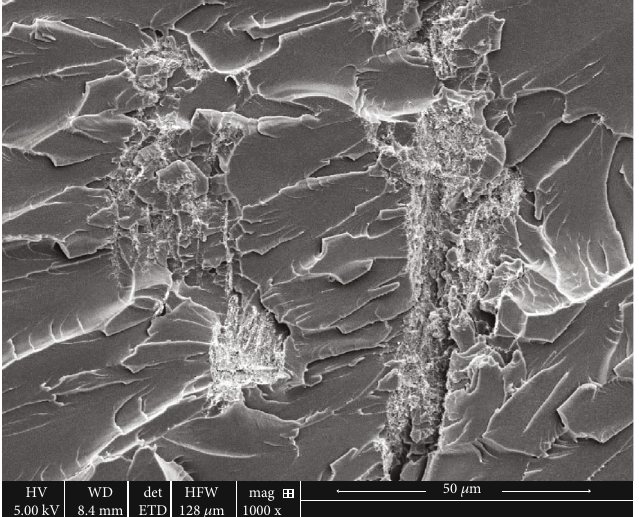
Figure 16: Fracture surfaces due to tensile failure in a 0.5wt.% MWCNT-reinforced epoxy composite subjected to 3000 thermal